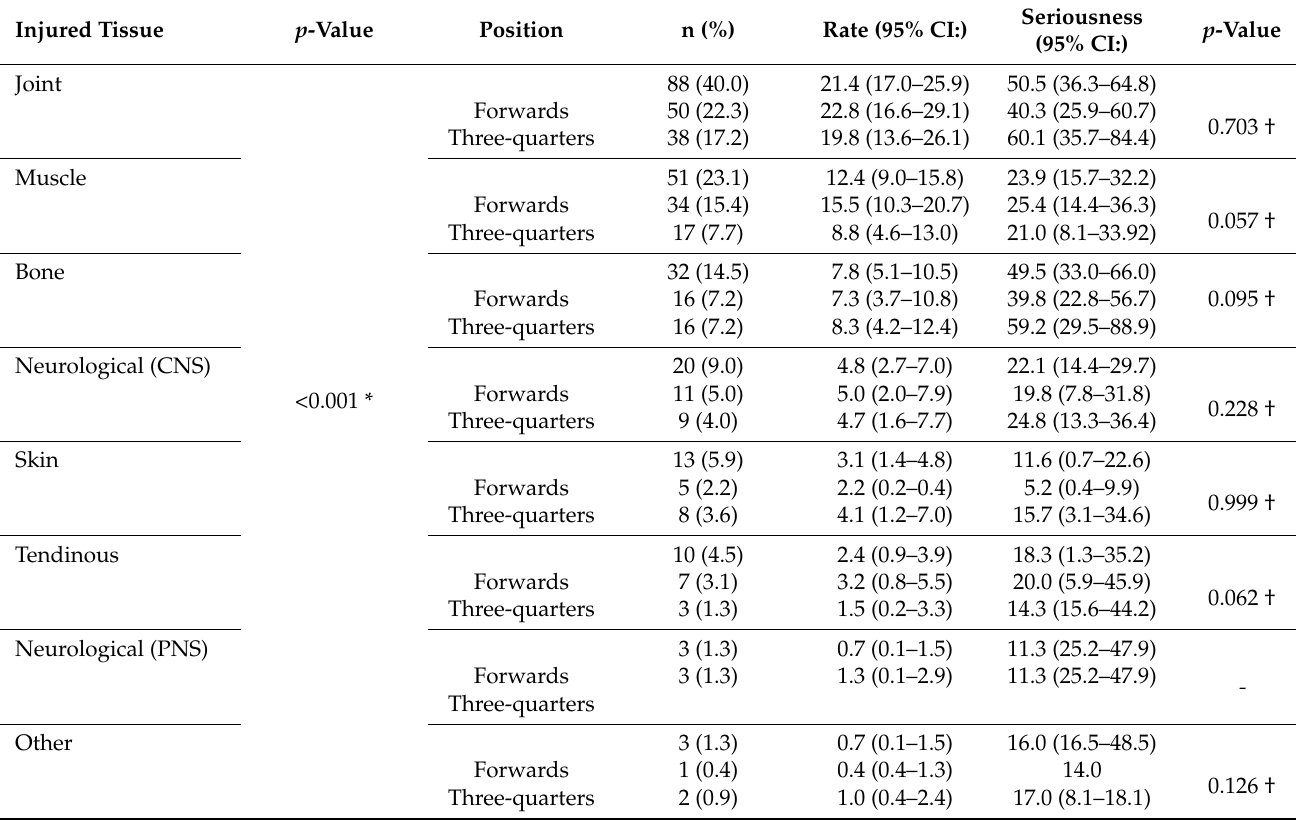
Table 4. Injury rate and seriousness distributed by injured tissue and